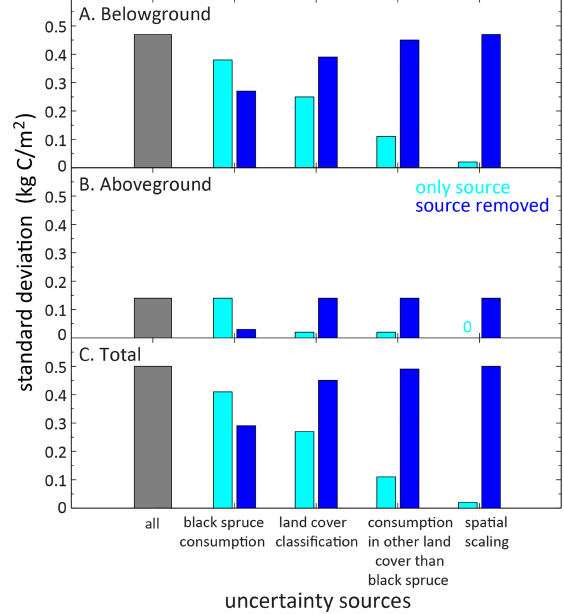
Figure 10. Distribution of (a) day of burning, (b) elevation, (c) pre- fire tree cover, (d) differenced normalized burn ratio of field observations ( n = 126) and region-wide Alaskan Fire Emissions Database (AKFED) between 2001 and 2012. The tree cover and differenced normalized burn ratio derived from the Moderate Reso- lution Imaging Spectroradiometer were converted to their Landsat- like values using the equations in Fig. S5. Data is plotted in the middle of interval boundaries on the x axis.